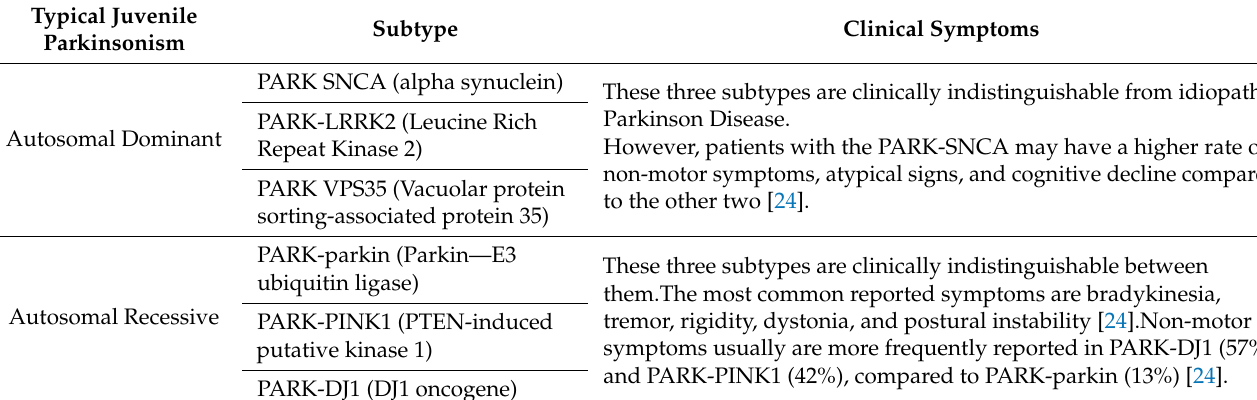
Table 1. Subtypes of typical Juvenile